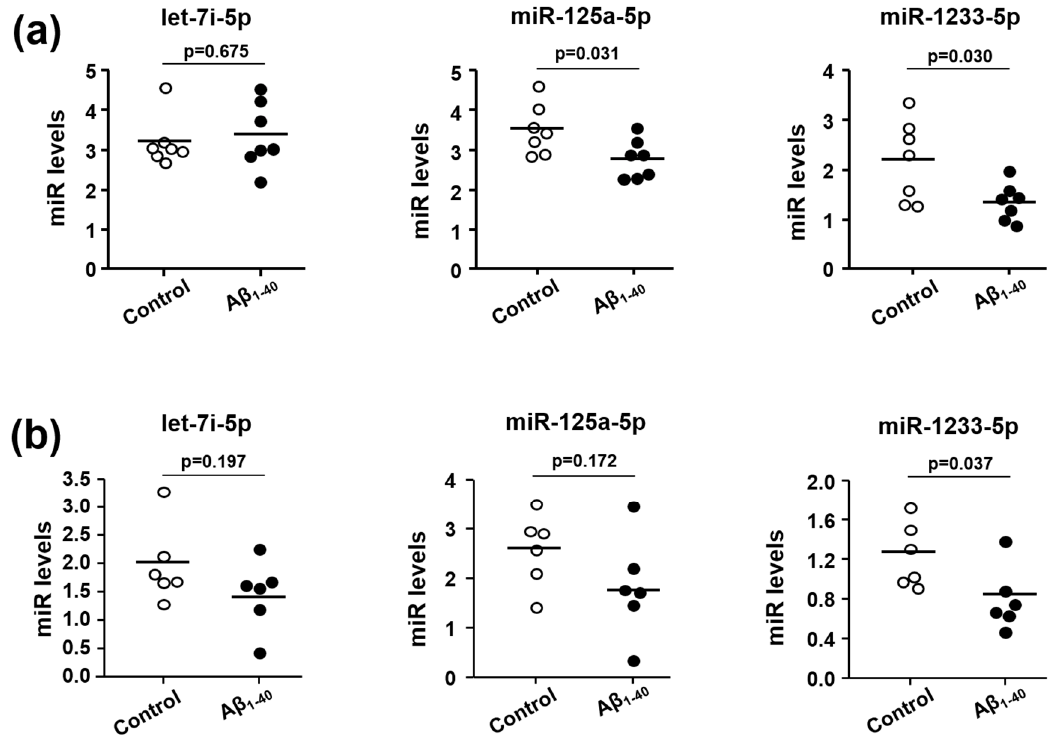
Figure 2. Direct effects of A β on let-7i-5p, miR-125a-5p, and miR-1233-5p expression in platelets ( a ) and MEG-01 cells ( b ). ( a ) Results obtained in healthy platelets (n = 7) in the absence or presence of 10 μ M A β 1-40 for 1 h. ( b ) Results obtained in human megakaryocytes (MEG-01 cells, n = 6) in the absence or presence of 10 μ M A β 1-40 for 1 h. Data are mean ± SEM.